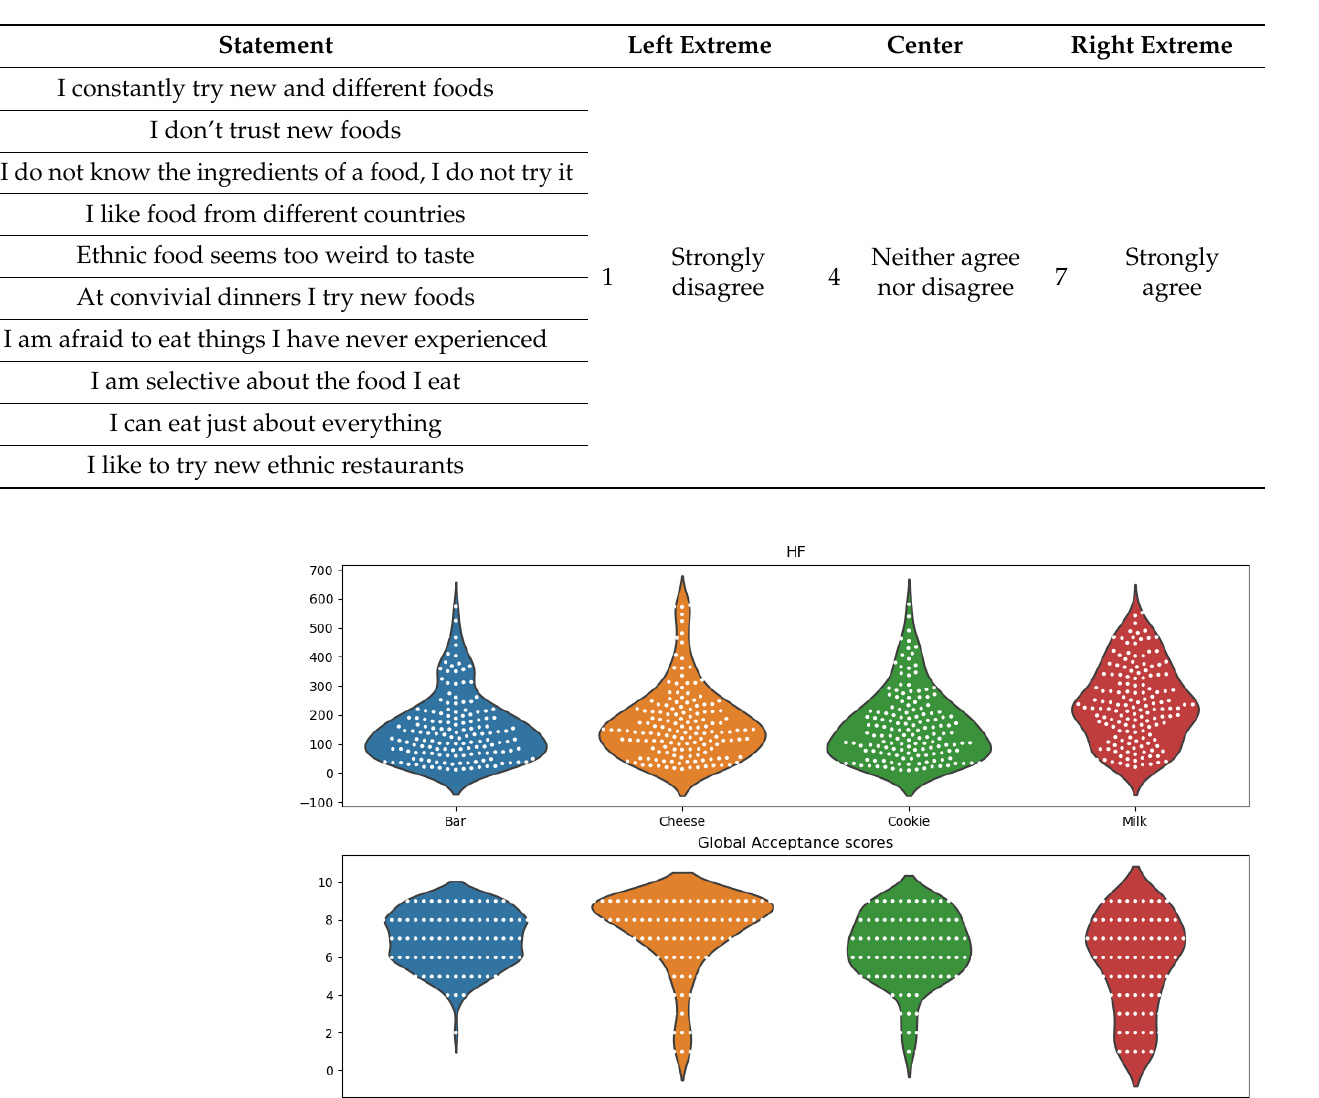
Table A1. Food neofobia assessment statements and scale used.